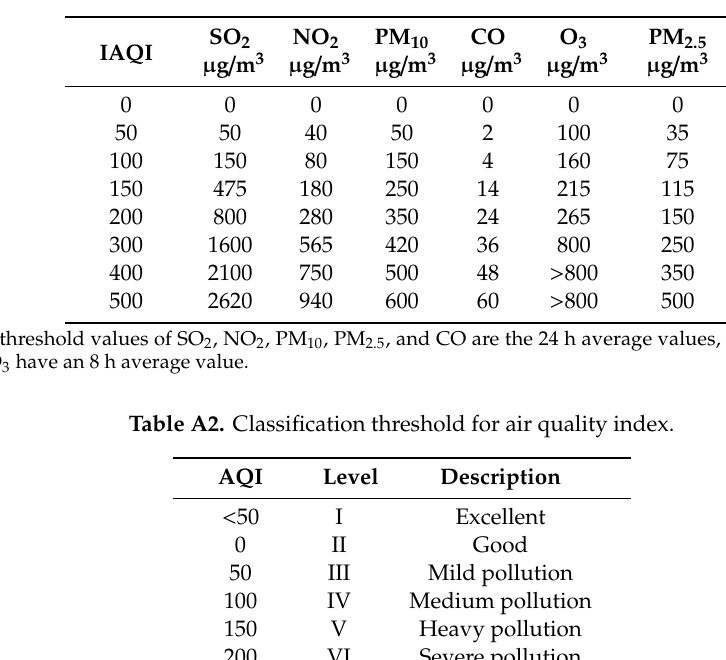
Table A3. Comparing the mean of heat risk index and HVI values in nine main urban